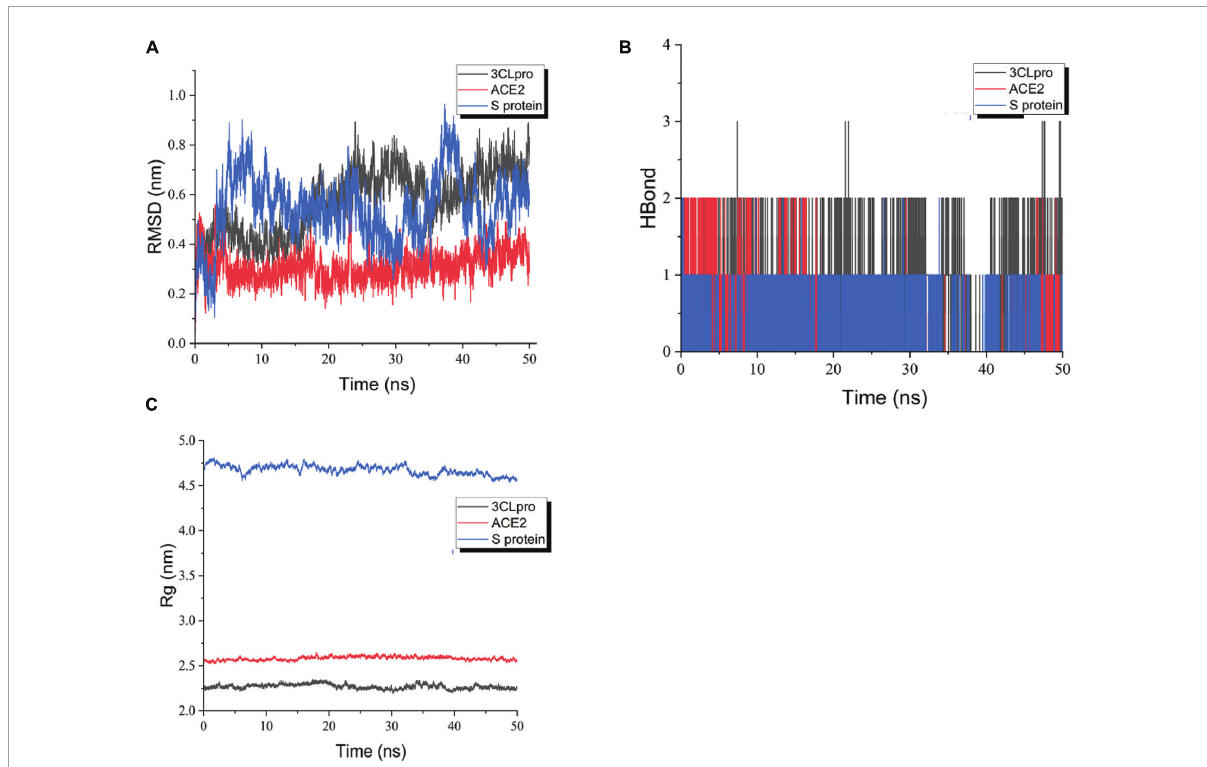
FIGURE11 RMSD plot during molecular dynamics simulations. (A) The RMSD of ligand-receptor. (B) The H-Bond of ligand-receptor. (C) The Rg of ligand-receptor. Blue polygonal line means shinflavanone and S protein, red polygonal line means shinflavanone and ACE2, black polygonal line means shinflavanone and 3-C like protease.